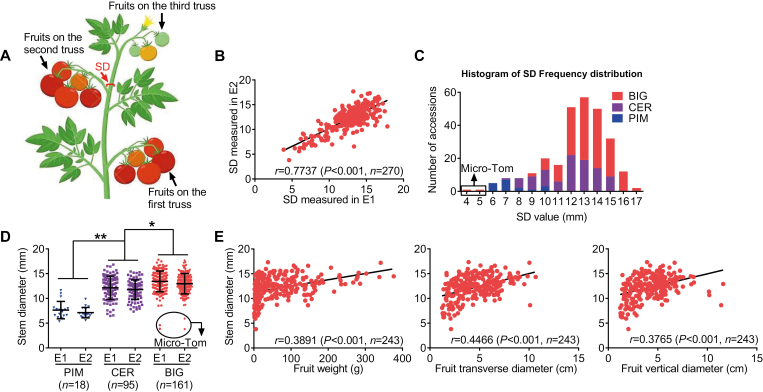
Generation and variation of phenotypic data. (A) Diagram showing the stem diameter (SD) measured in the study. (B) Correlation between SD values in plants from the collection of 270 tomato accessions grown in two different environments (E1 and E2). (C) Frequency distribution of SD in the three subgroups of the GWAS population. The arrow indicates two Micro-Tom accessions that belong to the BIG subgroup with small SD values. (D) Phenotypic variation of SD among the three subgroups of the GWAS population. The arrow indicates two Micro-Tom accessions. (E) Correlation between SD and fruit weight (left), fruit transverse diameter (middle), and fruit vertical diameter (right) in the natural population.